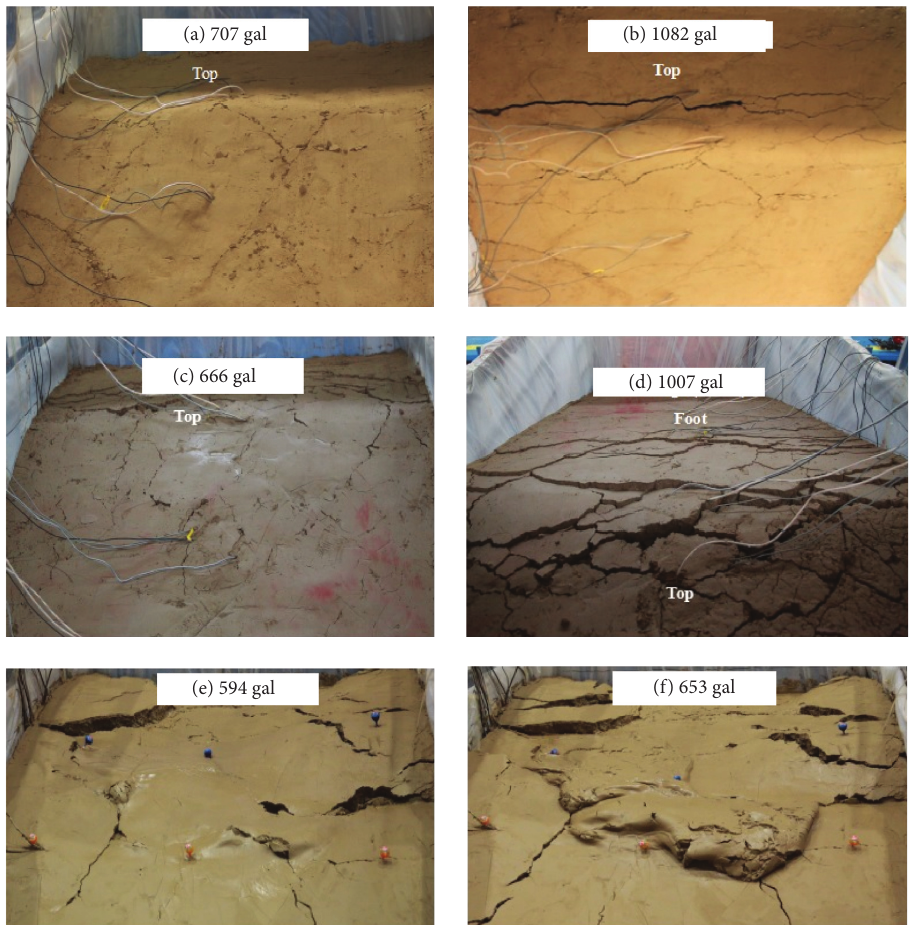
Figure 6: Macroscopic failure phenomenon of the slope model. (a)-(b) Natural state; (c)-(d) 10mm rainfall; (e)-(f) 100mm